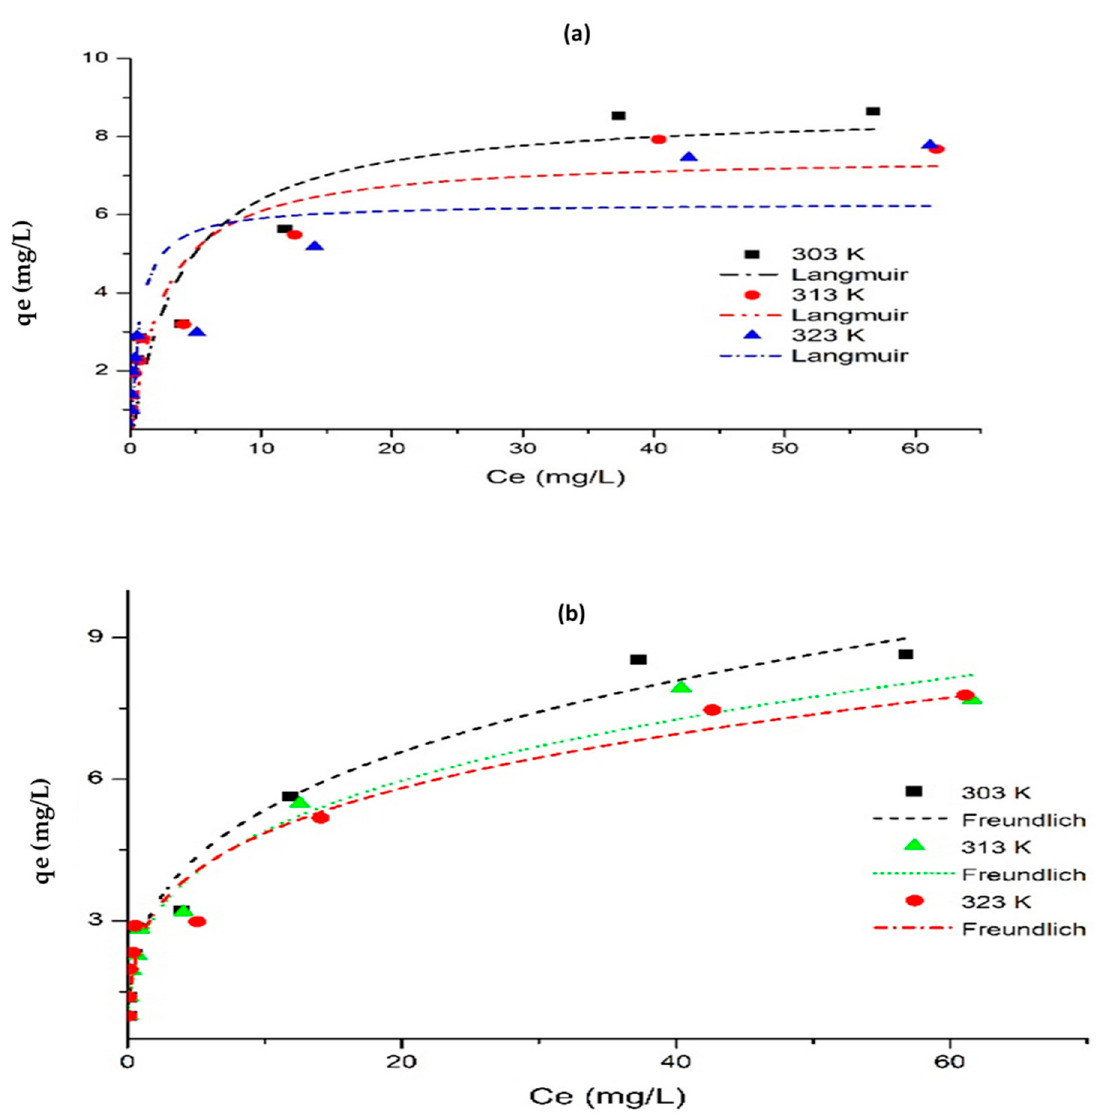
Figure 11. Nonlinear isotherms by ( a ) Langmuir and ( b ) Freundlich methods, for the sorption of fluoride by CNF-AgMgOnHaP composite at 303 K, 313 K, and 323 K. Table 3. Isotherm parameters for the sorption of fluoride by CNF-AgMgOnHaP composite.